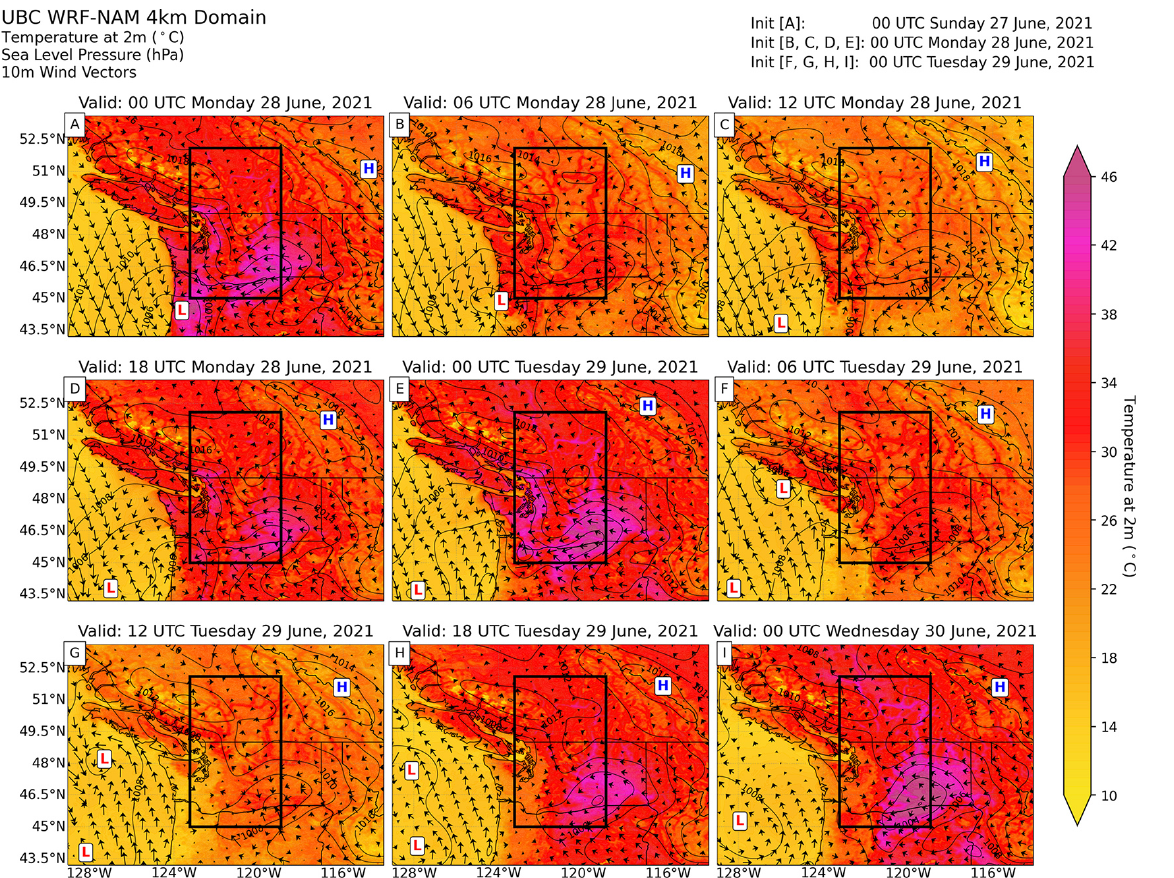
Figure 15. Regional simulation of sea level pressure, 2m air temperature and 10m wind velocity in the region containing the study area (black box) using the Weather Research and Forecasting (WRF; Skamarock et al., 2021) model forced by the North American Mesoscale Forecast System (NAM). Panels (a) – (i) show the evolution of the near-surface dynamics at a 6h interval from 00:00UTC on 28 June through 00:00UTC on 30 June 2021. Of note is panel (e) , which shows 17:00 local time on the day of peak temperature for Portland, Seattle and Vancouver. The H and L in the panels indicate high and low